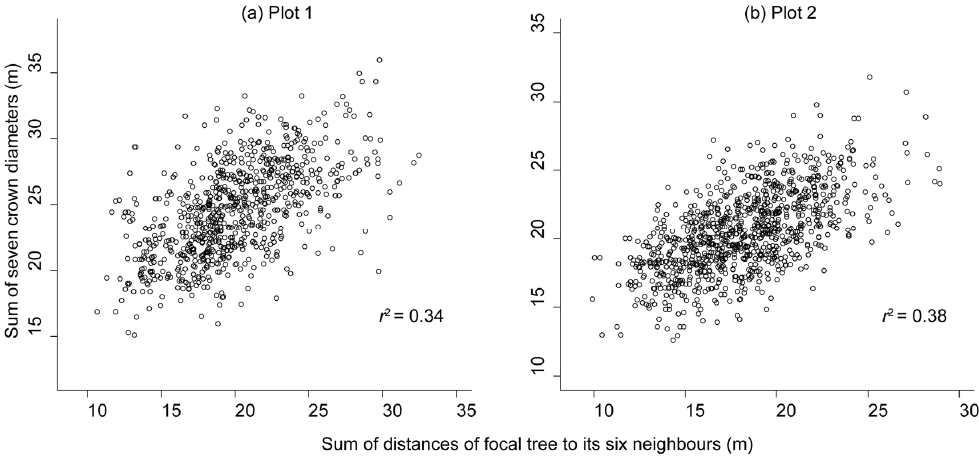
Figure 4. Relationship between the sum of the crown length of the nearest neighbours plus the crown length of a focal tree and the sum of the distance of a focal tree to its nearest neighbours .